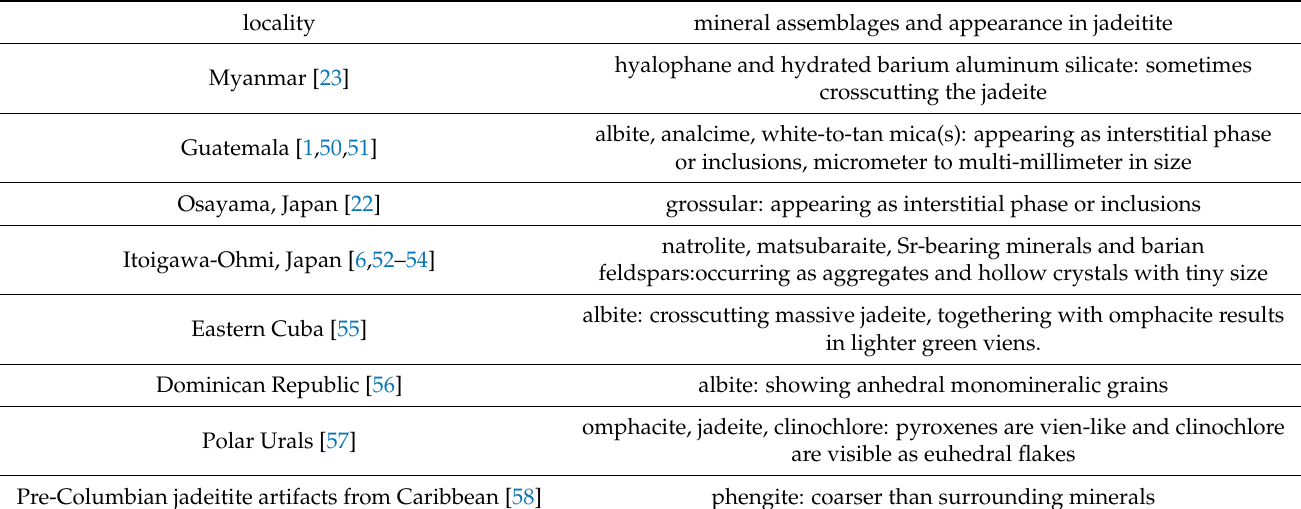
Table 2. Interstitial phases occurring in jadeitite from different localities and their mineral assemblages. mineral assemblages and appearance in